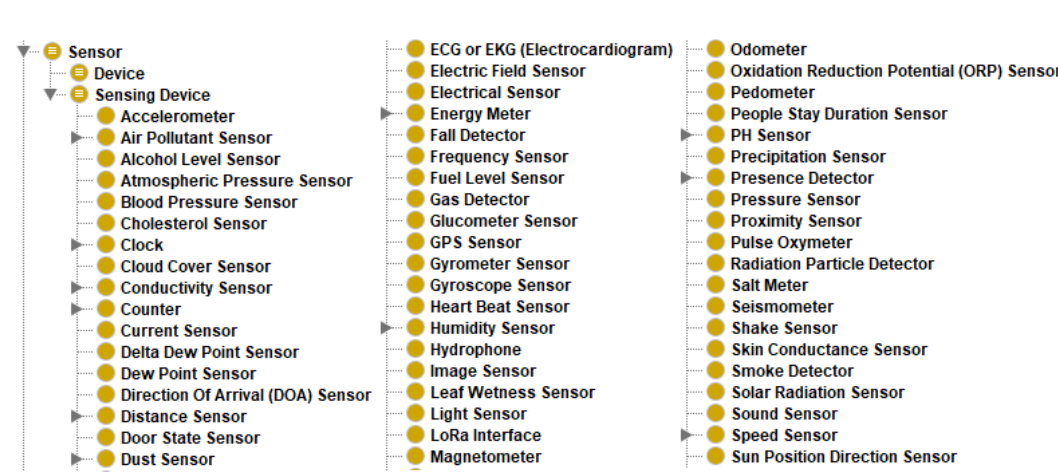
Figure 2. Excerpt from sensor types described in Semantic Sensor Network Ontology.